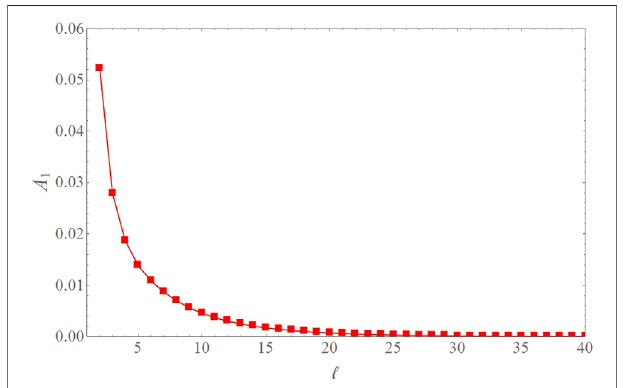
FIGURE7| Thedipoleamplitude A 1 ( ℓ )generatedinLQC.Planckreports a value of A 1 ≈ 0.07 in the multipole bin ℓ ∈ [2, 64].